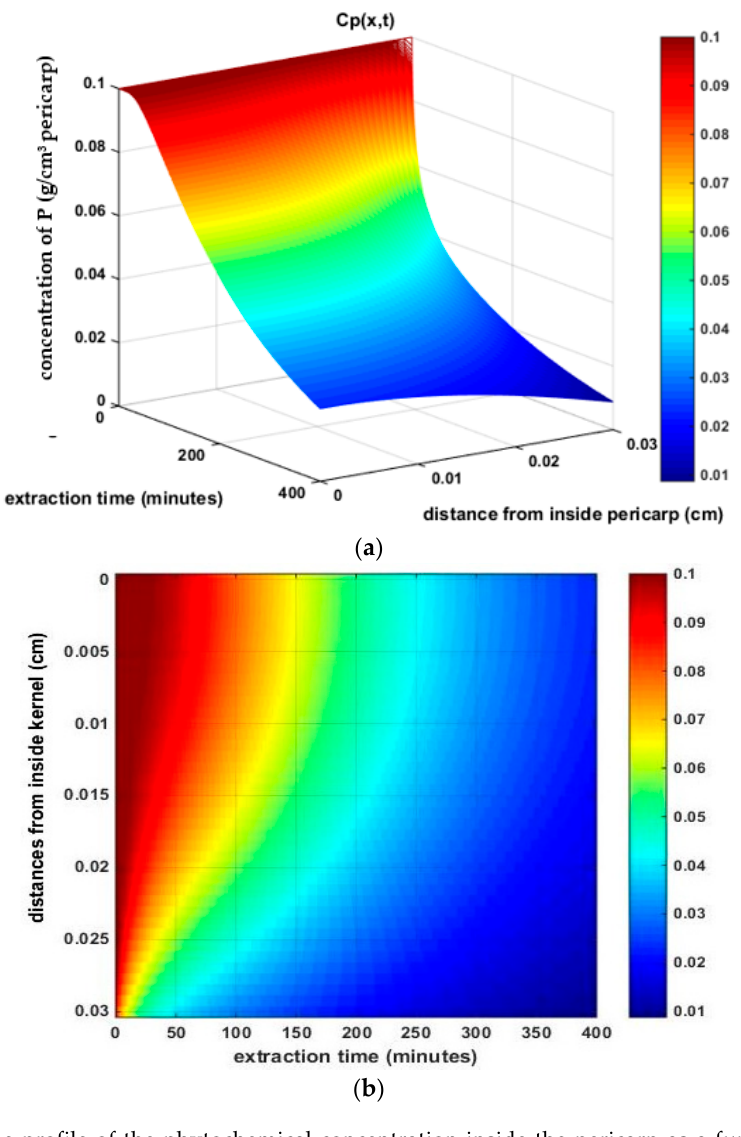
Figure 2. The profile of the phytochemical concentration inside the pericarp as a function of: ( a ) position; and ( b ) extraction time.